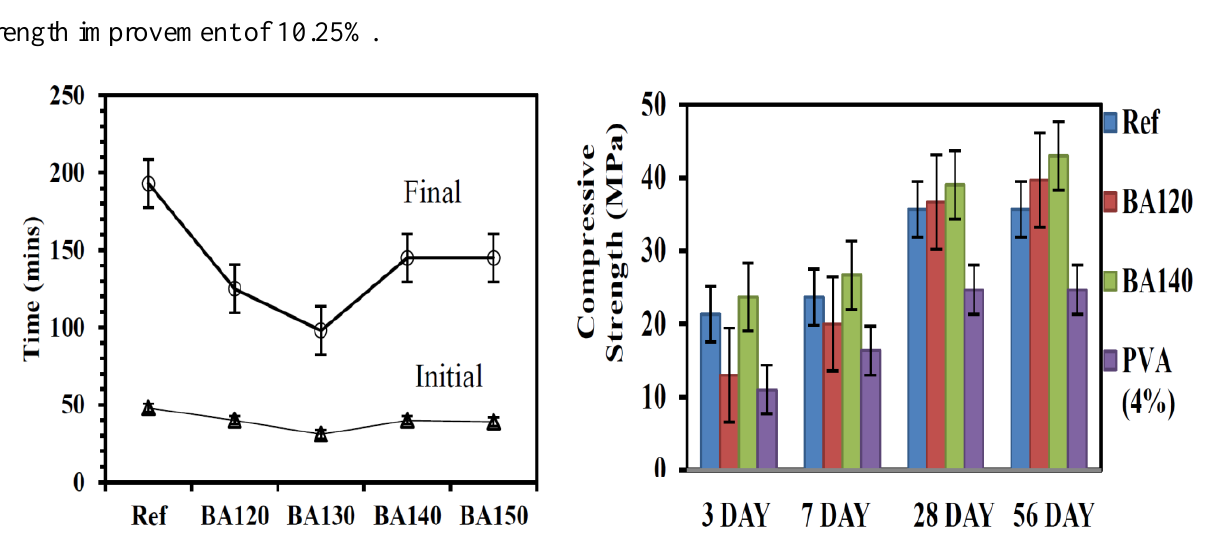
Figure 11. Test results extract okra effecting on concrete properties (Hazarika et al. [18]) Studies conducted by Paul Shaji et al. [20] observed that 0.9% of natural rubber latex improves con- crete’s compressive strength with a good compacting factor value.